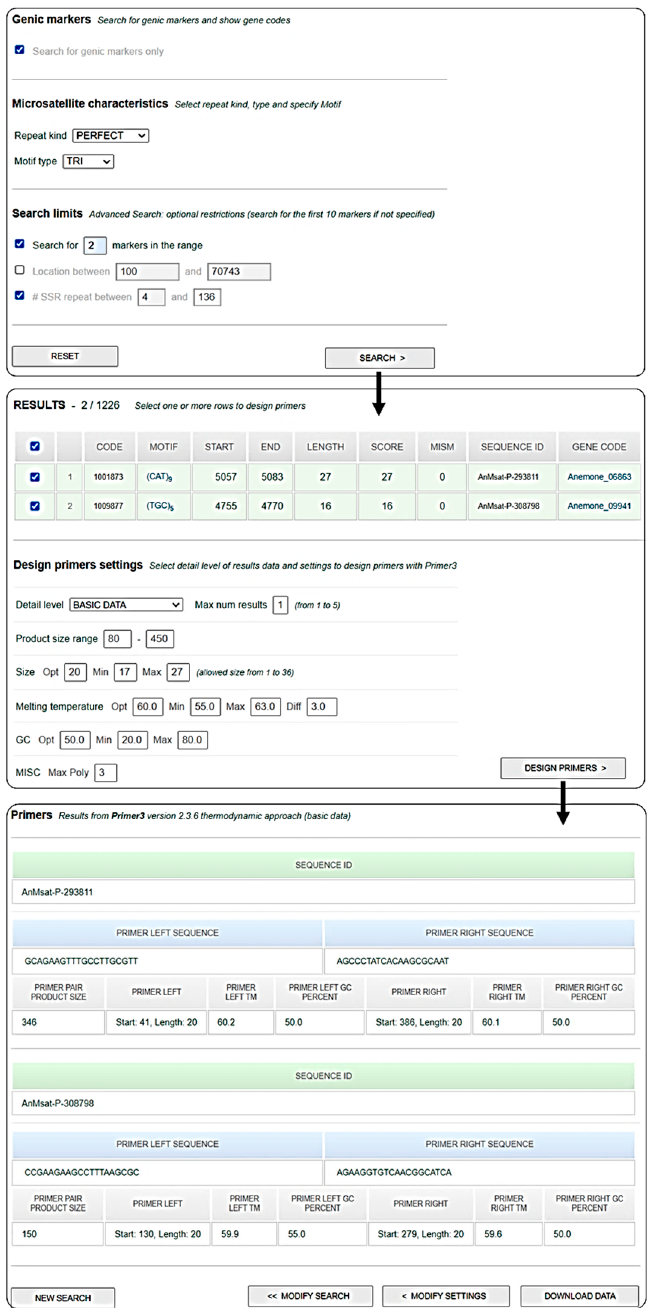
Figure 6. Example of SSR search and primer design at AnCorDB.